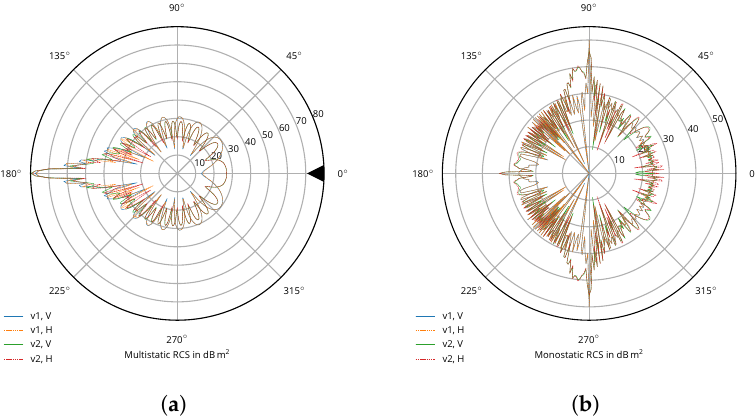
Figure 2. Comparison of the radar cross section (RCS) (in dBm 2 ) of the nonrotating components of WT v1 and WT v2. The different tower shapes cause significant changes in the RCS, especially in the monostatic case (at 0 ◦ ) with more than 10dB difference. This is also the case for the tower with nacelle and hub, where the flat shape of WT v1 causes very strong peaks into a single direction. ( a ) Multistatic RCS: tower only; ( b ) monostatic RCS: tower with nacelle and rotor